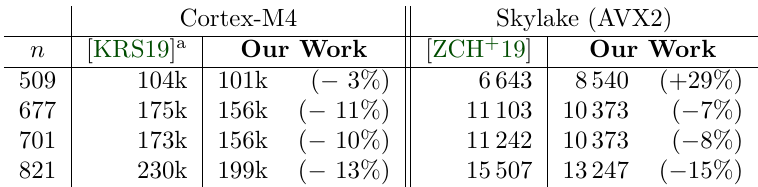
Table 7: NTRU Performance results in clock cycles for polynomial multiplication on Cortex-M4 and